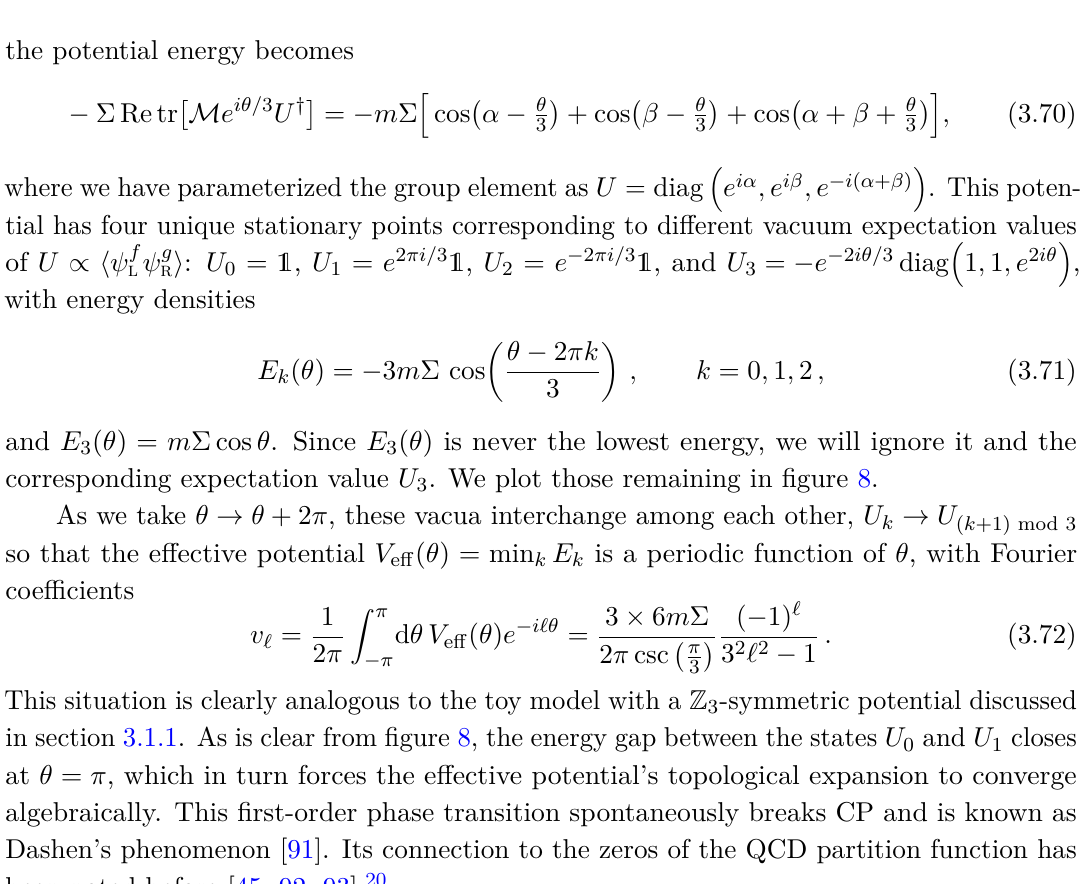
Figure 8. The energies E k ( θ ) in units of 3 m Σ . As θ → θ + 2 π , the vacua interchange among one another so that the minimum energy or effective potential is 2 π